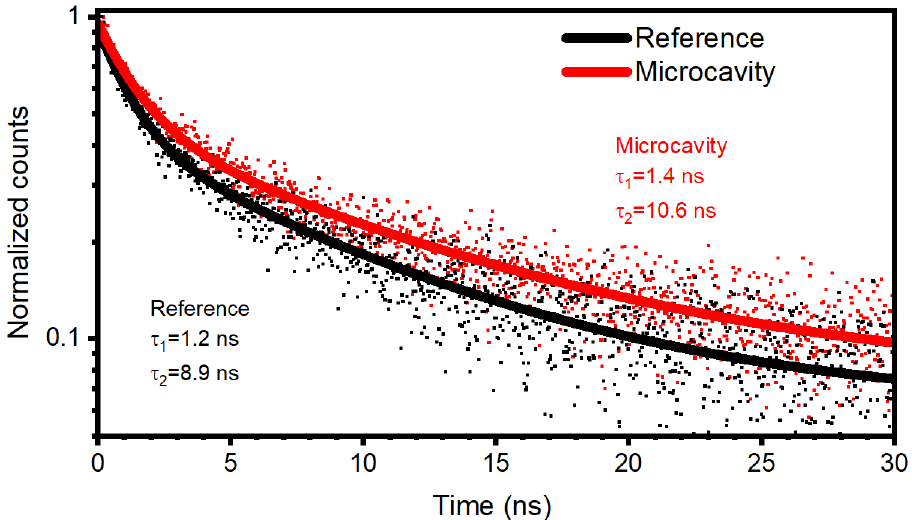
Figure 5. Emission decay collected at 615 nm for the reference sample (black lines) and for the microcavity (red line). All the data were collected at 28° from the normal incidence to the sample plane.